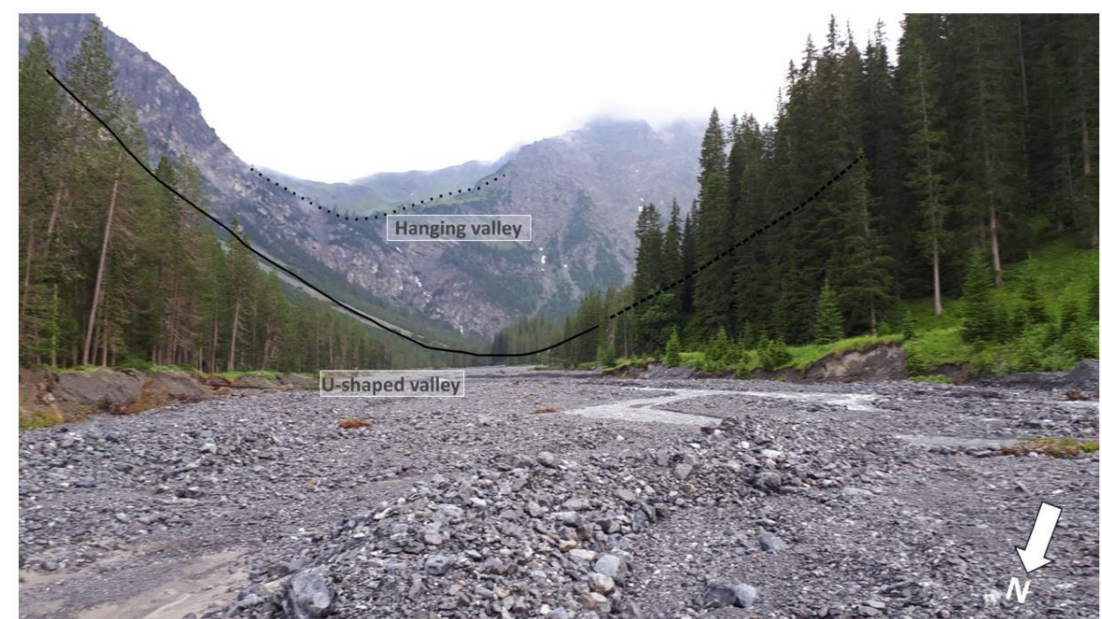
Figure 4. Picture of a U-shaped valley and an associate hanging valley in the Welschtobelbach sub-catchment, nearby the PLE09 site (Figures 2 and